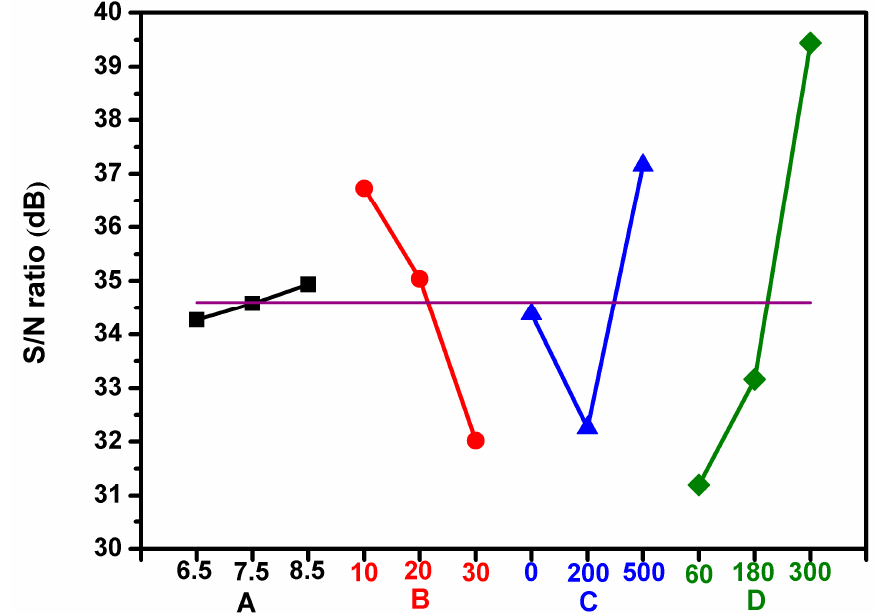
Figure 5. Taguchi analysis determines the best set of parameter combination. The effect diagrams for antimicrobial of CAPJ are based on the higher S/N and the better efficiency. Four factors include A: applying voltage (kV), B: CAPJ-sample distance (mm), C: Ar gas flow rate (sccm), and D: CAPJ treated